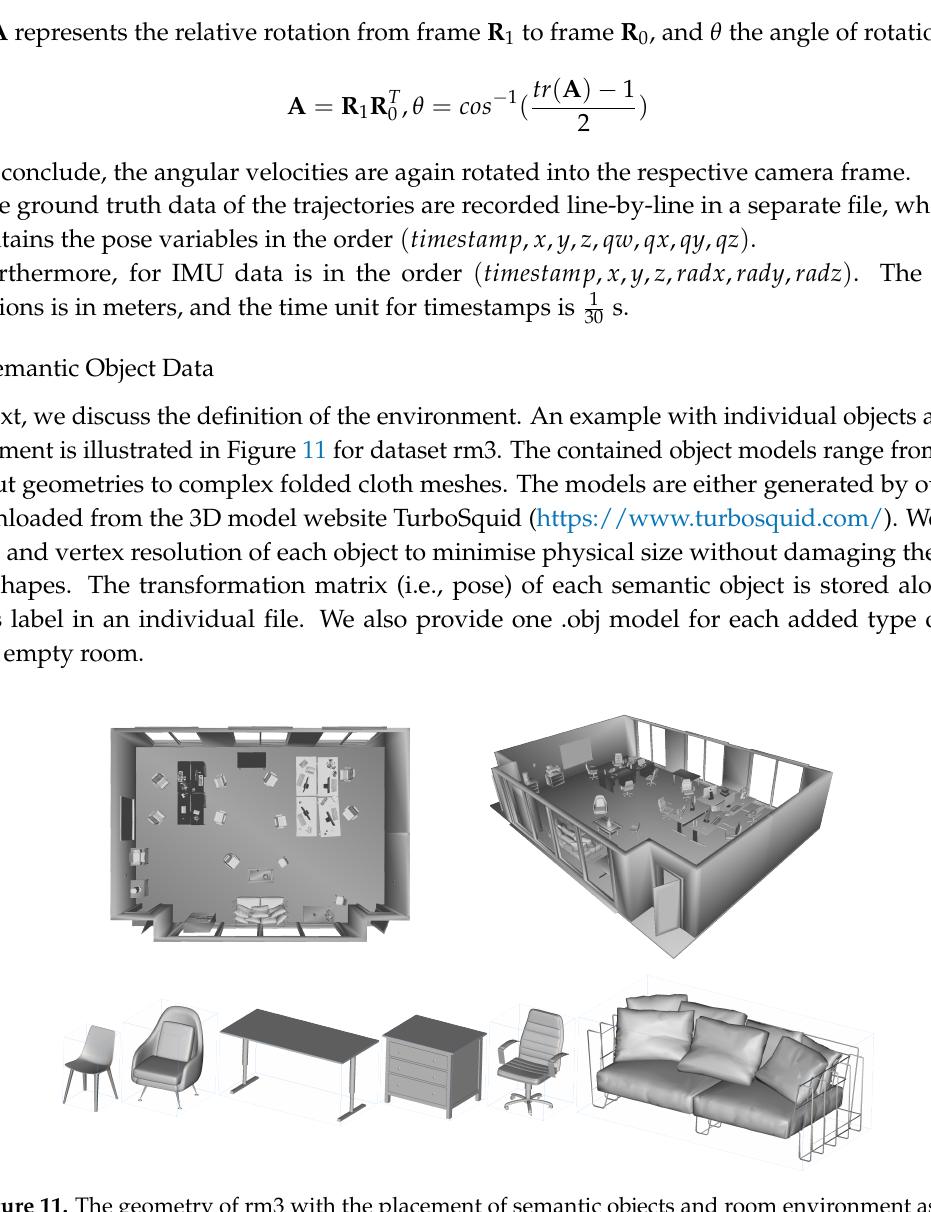
Figure 11. The geometry of rm3 with the placement of semantic objects and room environment as an illustration of the composition of our dataset. The image below shows calibrated semantic objects in their initial canonical